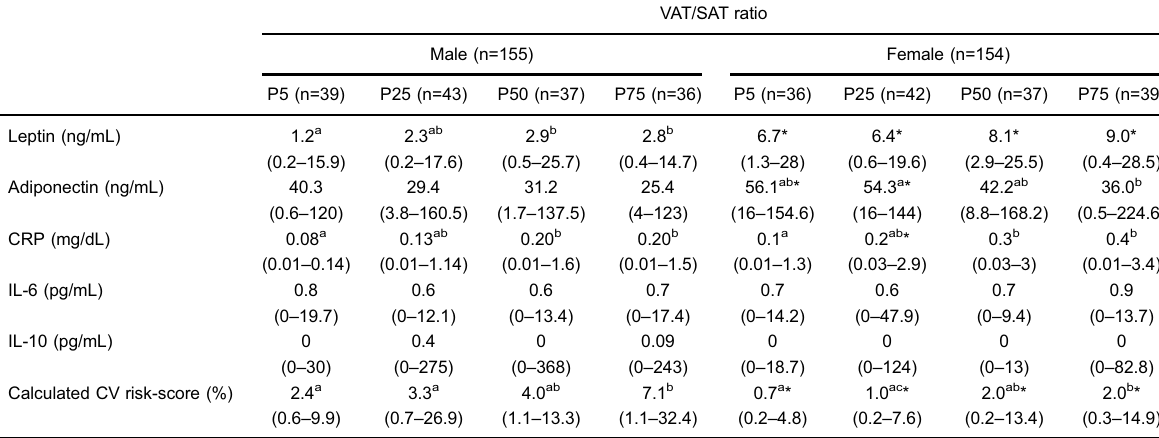
Table 1. In fl ammatory markers according to quartiles of the VAT/SAT